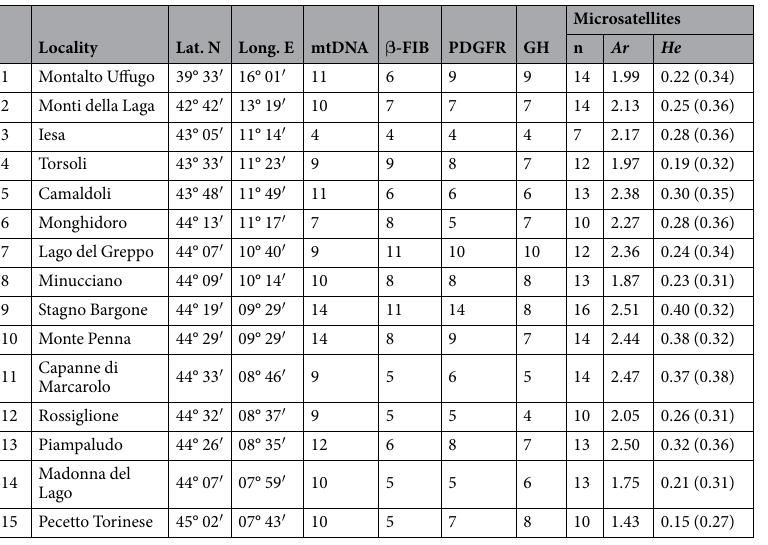
Table 1. Geographical locations of the 15 Ichthyosaura alpestris sampling sites, sample sizes for each gene studied, and estimates of genetic variability at microsatellite loci for each population. n, sample size; Ar, allelic richness; He, expected heterozygosity (with standard